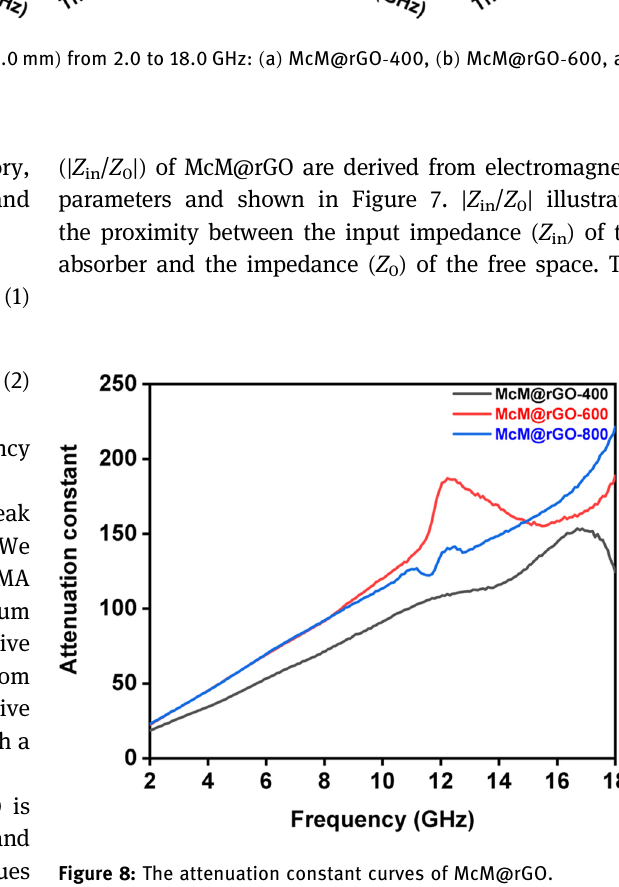
Figure 8: The attenuation constant curves of